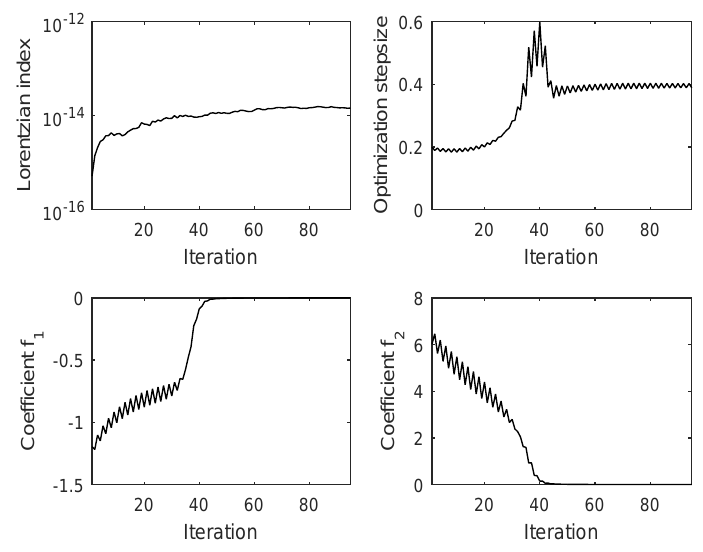
Figure 6. Minimization of the criterion function in Equation (28) over the pseudo-orthogonal group O ( 10,5 ) : Values of the index (cid:107) X (cid:62) R p , q X ( (cid:96) ) − R p , q (cid:107) F and of the coefficients ˆ t ( (cid:96) ) , ˜ f 1 ( (cid:96) ) and ˜ f 2 ( (cid:96) ) ( (cid:96) ) during iteration.